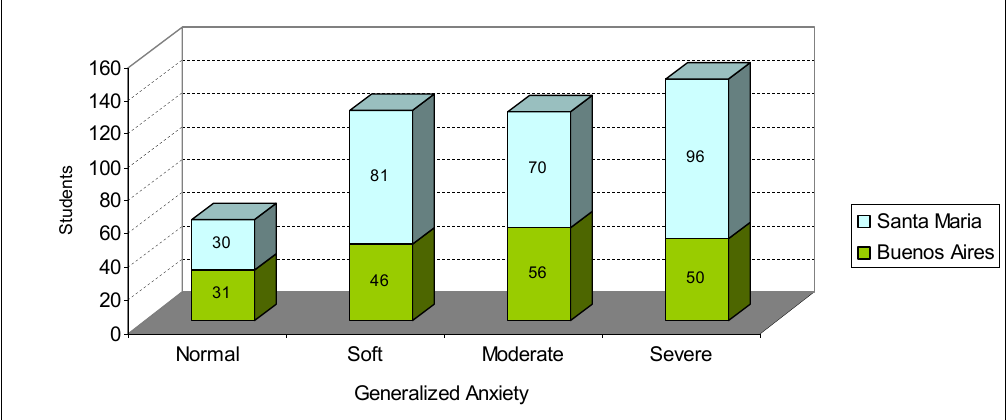
Figure 7. General anxiety disorder levels among students from Buenos Aires and Santa Maria. Source: survey data.